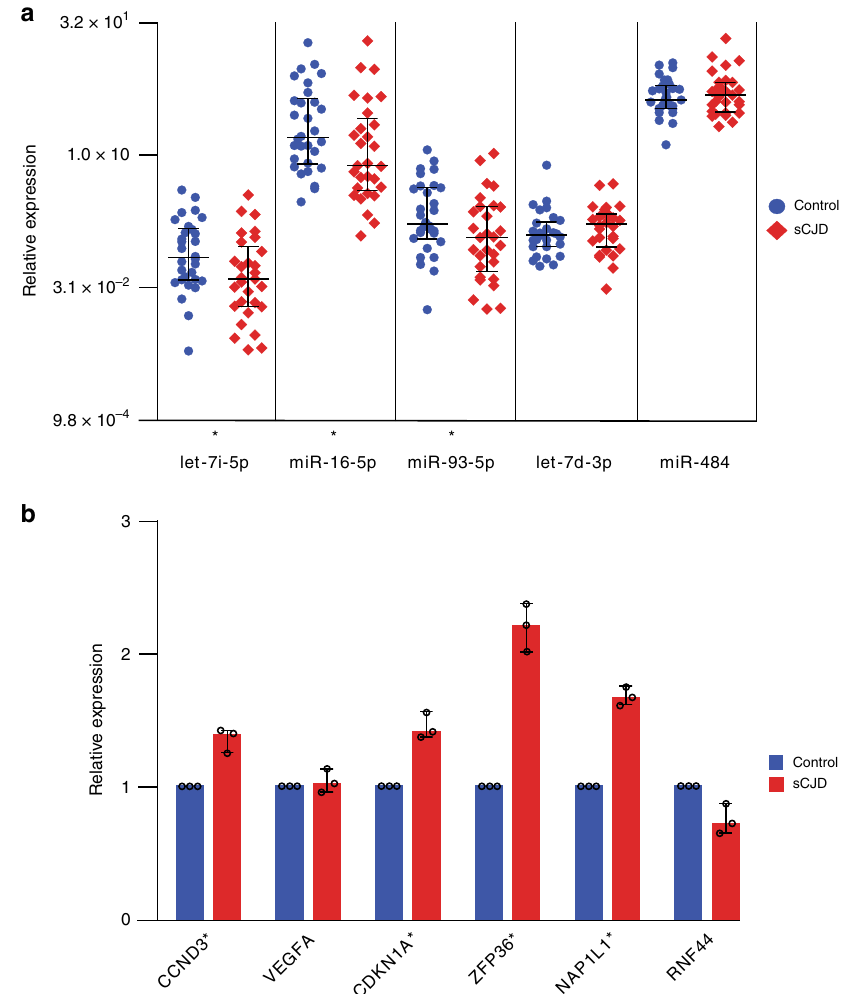
Fig. 2 Validation and replication of DE miRNAs, and expression of target mRNAs. Expression of DE miRNAs ( a ), relative to the control small RNA RNU6-2 with median and interquartile range, are shown for both control and sCJD groups. One-sided Mann – Whitney tests were used to generate p -values. Fold change (FC) as follows: hsa-let-7i-5p FC − 1.82, p = 0.014; hsa-miR-16-5p FC − 1.87, p = 0.023; hsa-miR-93-5p FC − 1.74, p = 0.023; hsa-let-7d-3p